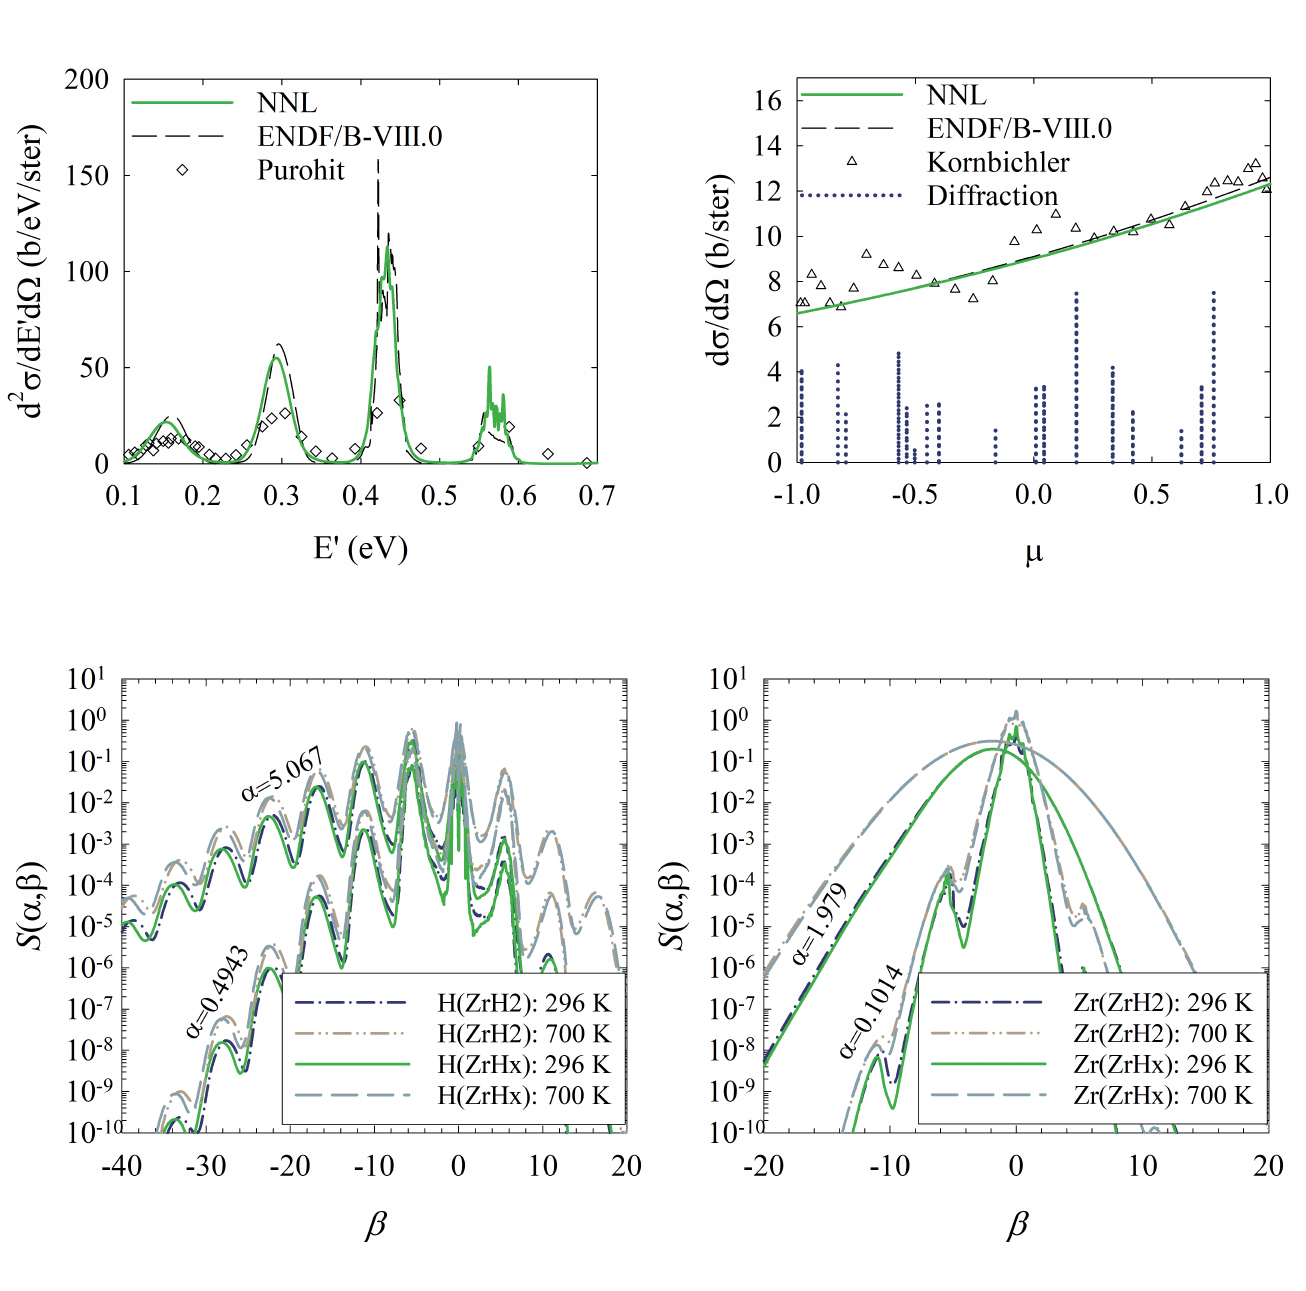
Figure 3. Computed double-differential cross section of (cid:101) -ZrH 2 for E = 0.572 eV and µ =0.766 (top left) and differential cross section of (cid:101) -ZrH 1.92 for E = 0.0225 eV (top right) compared to the experiment, Purohit [28] and Korbichler [29]. TSL for H (bottom left), and Zr (bottom right) in δ -ZrH x and (cid:101) -ZrH 2 are shown at 296 K and 700 K. Both α and β are referenced to 293.6 K (i.e., k B T = 0.0253 eV). The double-differential scattering cross sections for the present Naval Nuclear Laboratory (NNL) and ENDF/B-VIII.0 TSL evaluations were generated with the FLASSH code [11]. The diffraction peaks in the differential scattering cross section indicate the location of contributions from coherent elastic scattering in the NNL evaluation that are not included in the NNL plot. Diffraction presents as a deviation from continuous behavior in the experimental differential cross section. Experimental double-differential cross sections were obtained from the time of flight